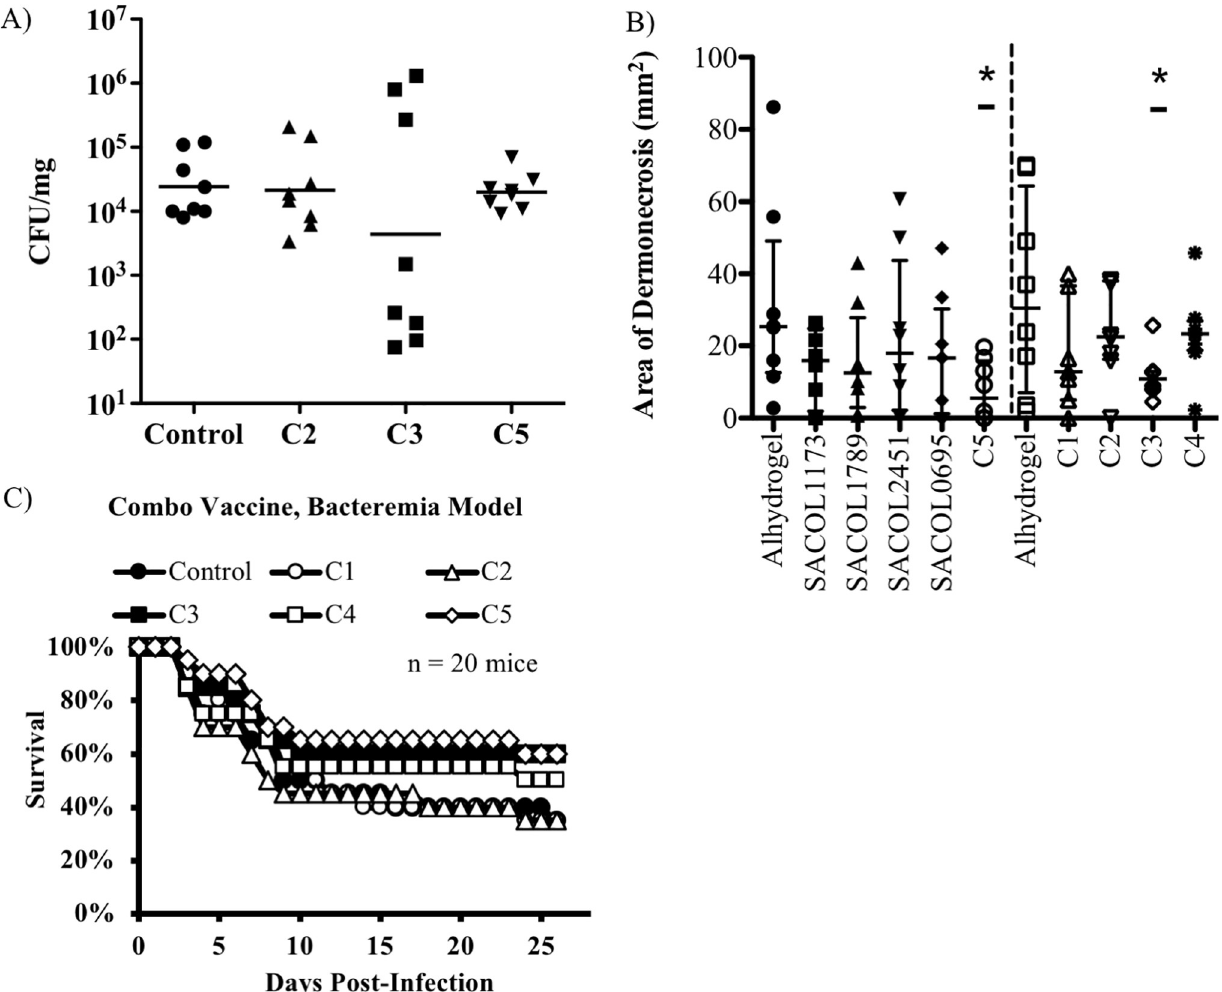
Fig 5. Combination vaccines. Combinations of antigens that offered protection in the bacteremia model (SACOL2451 and SACOL0695) were combined with antigens that were found to be protective in the skin model (SACOL1173 and SACOL1789). A, B) Skin infection model. BALB/c mice (n = 8) were immunized and then challenged with a S . aureus in a skin infection model. Combination groups “C3” and “C5” were able to reduce the area of dermonecrosis relative to the Alhydrogel control (Wilcoxon rank-sum, p < 0.05) but the reduction in CFU burden was not statistically significant (n = 8 mice per group). C) Bacteremia model. BALB/c mice (n = 20) were immunized with antigen combinations and then challenged with a S . aureus IV infection. Mice were monitored daily and euthanized when moribund. Combination groups "C3", "C4", and "C5" resulted in a greater number of mice surviving but this was not statistically significant (n = 20 mice per group). “C1” = SACOL1173, SACOL1789, SACOL2451, and SACOL0695; “C2” = SACOL0695, SACOL1789, and SACOL2451; “C3” = SACOL0695, SACOL1173, and SACOL2451; “C4” = SACOL1173, SACOL1789, and